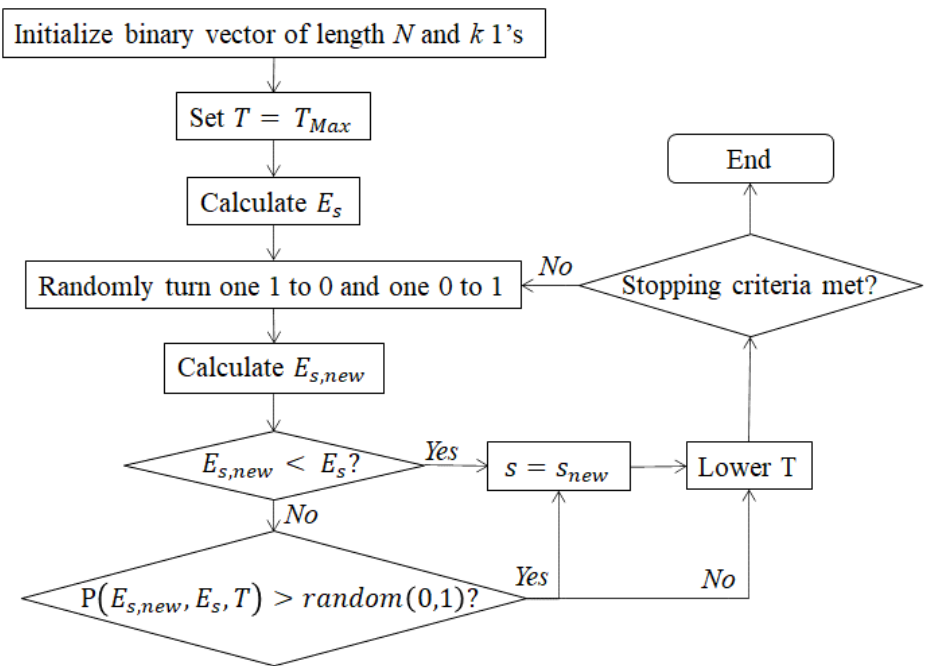
Figure 3. Flowchart for the simulated annealing algorithm used to select the best k wavelengths for SO 2 estimation. SO 2